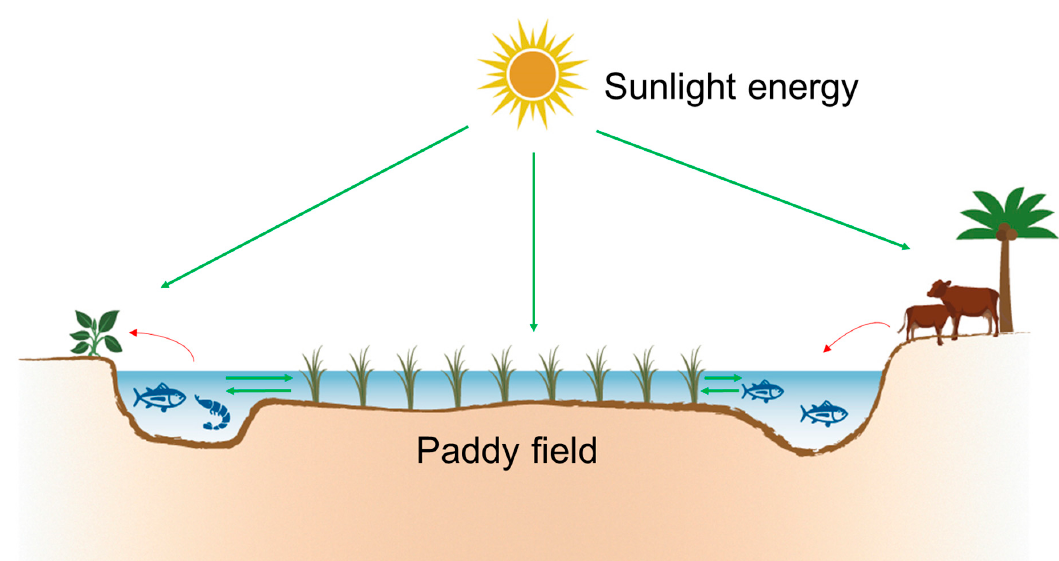
Figure 1. Material flow in integrated agriculture–aquaculture.